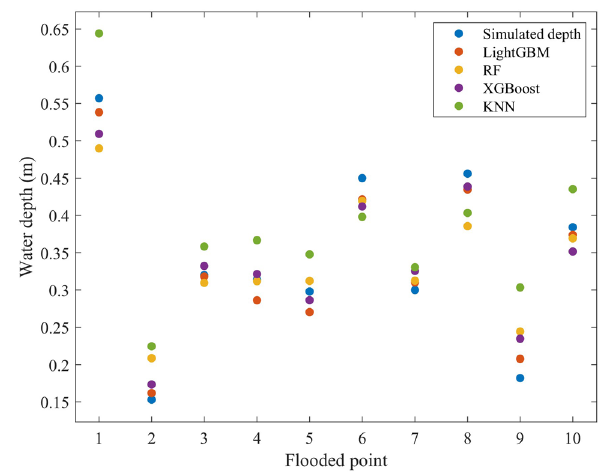
Fig. 14 Scatter distribution of predicted and simulated values for each machine learning model Table 7 Comparison of the evaluation index values of each model in the prediction stage